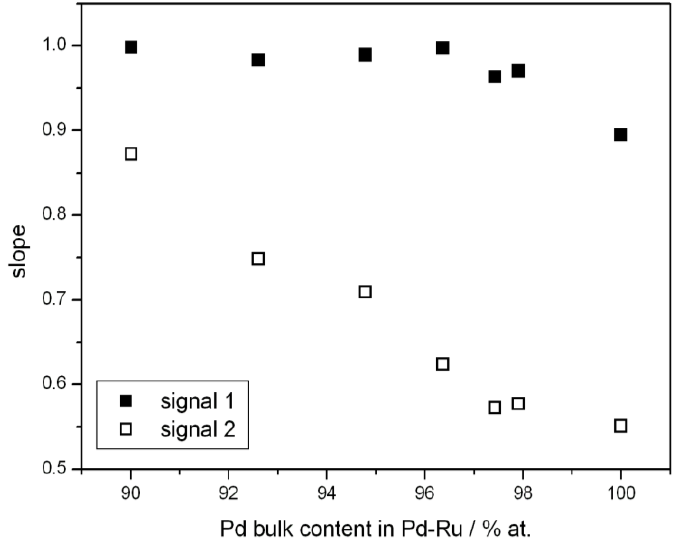
Figure 3. Influence of bulk composition of Pd-Ru alloys on the slope of log I vs. log v plot for signals 1 and 2. Temperature 298